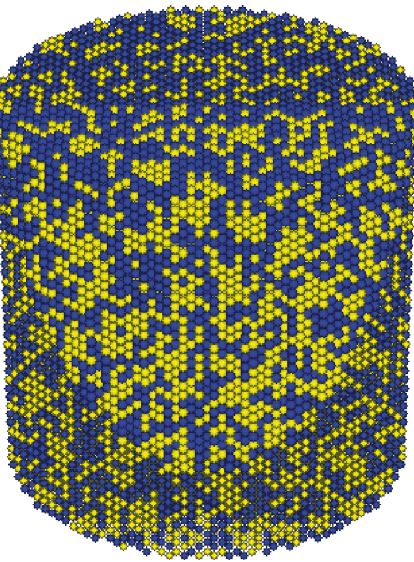
Figure 6: Specimen of irregular aggregate (no air voids).